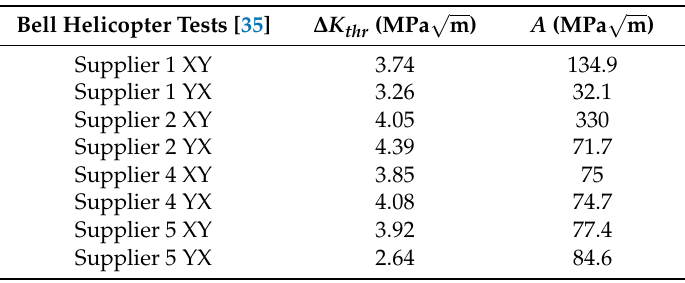
Table 1. Values of ∆ K thr and A used in Figure 1 and identified by global optimization of Equation